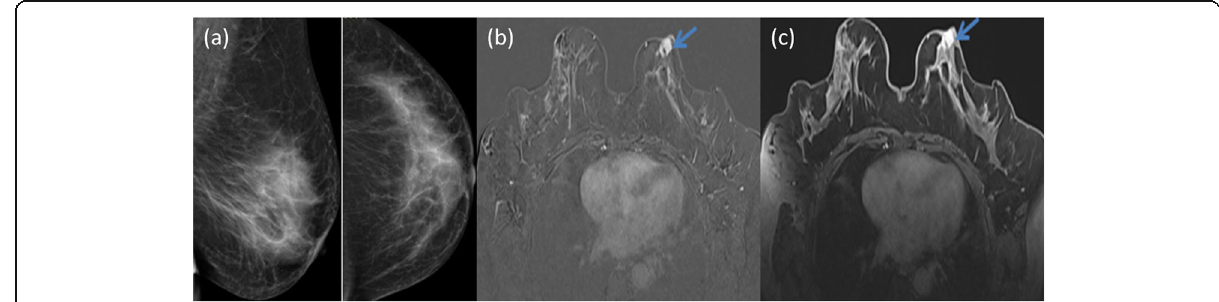
Fig. 3 A case of pathologically proven invasive tubular cribriform carcinoma with skin invasion (T4N0). a Mammgraphy showed no spiculated mass lesions or microcalcific clusters, complementary ultrasound suspected left retroareolar irregular lesion with posterior shadowing related to the nipple. b , c DCE-MRI showed clearly left non-circumscribed ovoid mass related to the posterior aspect of the nipple. It is seen eliciting intense heterogeneous enhancement with central non-enhancing core, facilitated diffusion was noted on DWI-MRI. In this case, the lesion was detected by DCE-MRI and was subtle sonsonography yet missed on mammography and